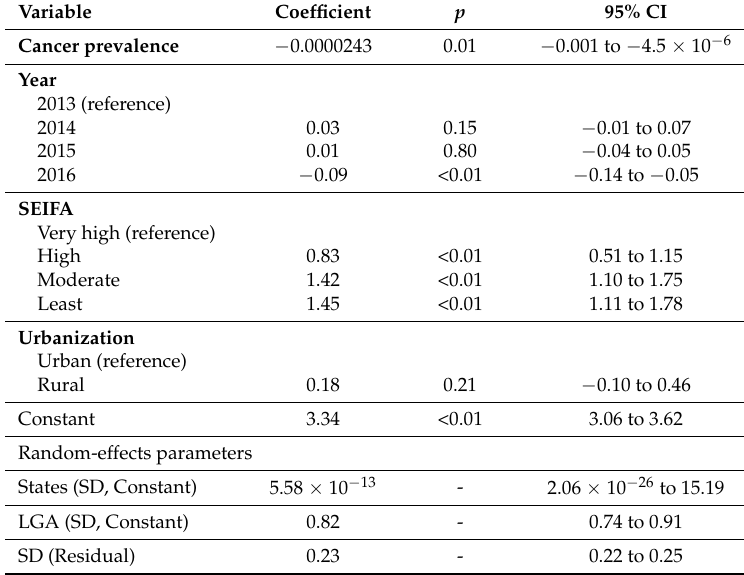
Table 2. Association between LGA-level DDD/1000 people/day and covariates in multilevel